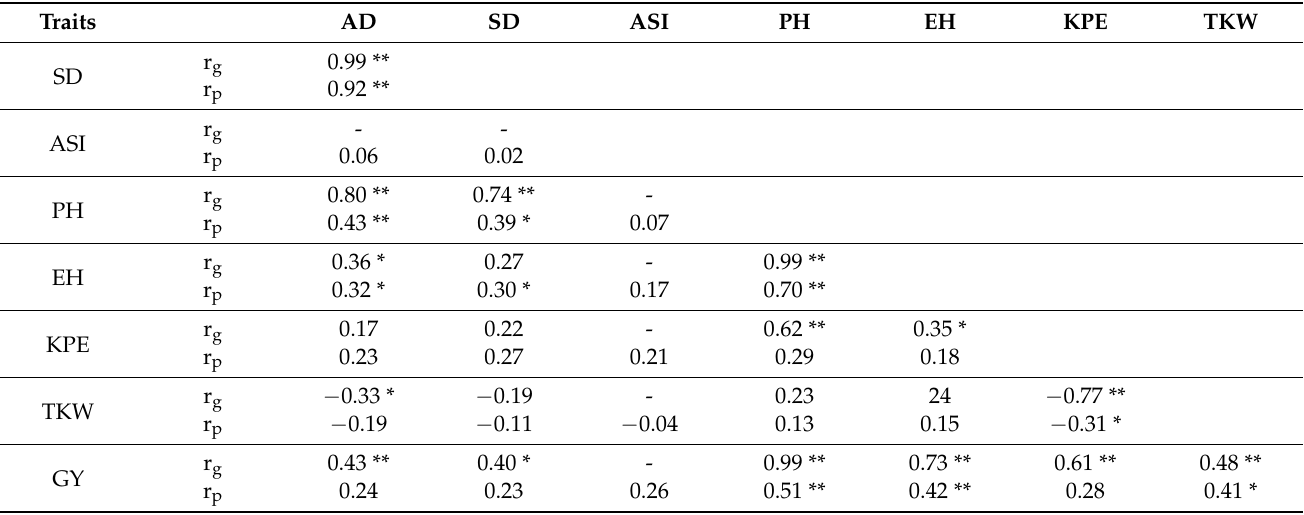
Table 2. Associations of different traits from trial evaluated at Barishal location.